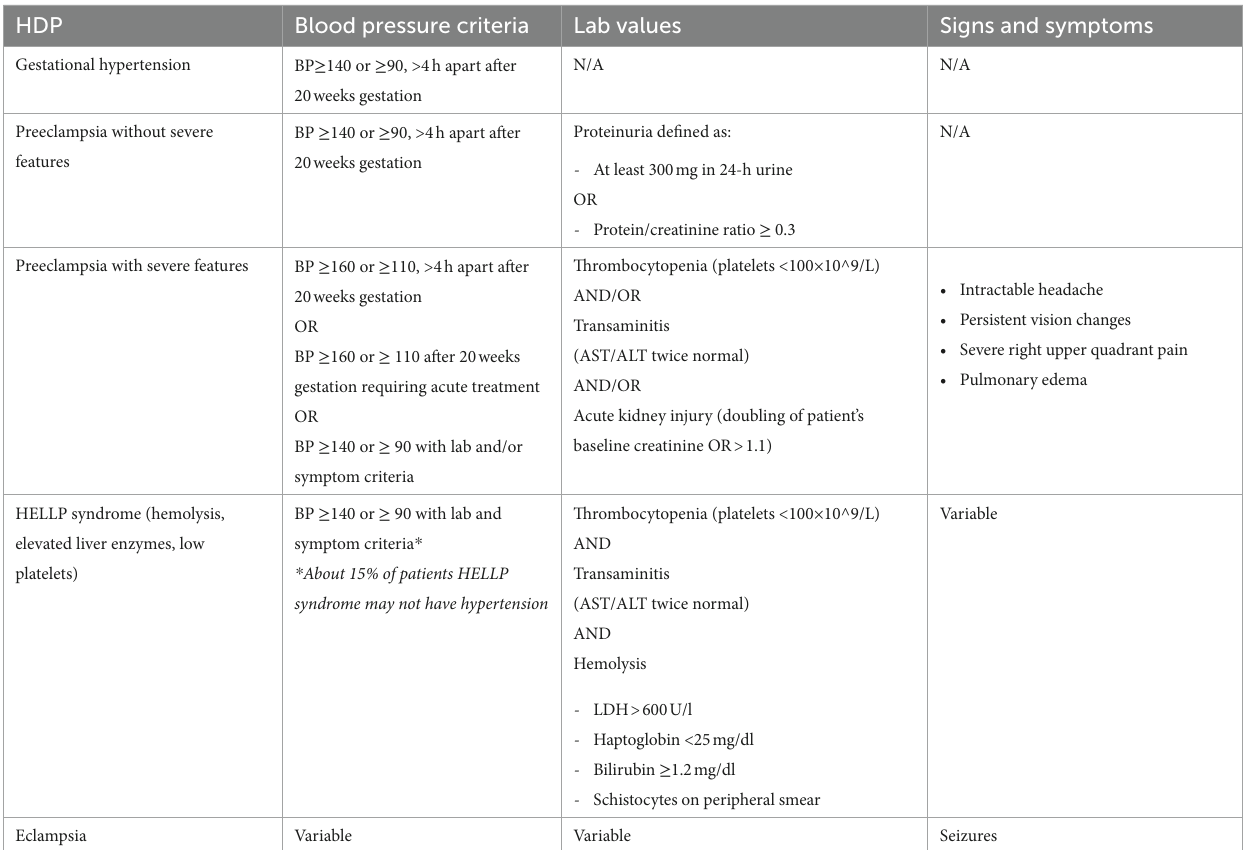
TABLE 1 Diagnostic criteria for